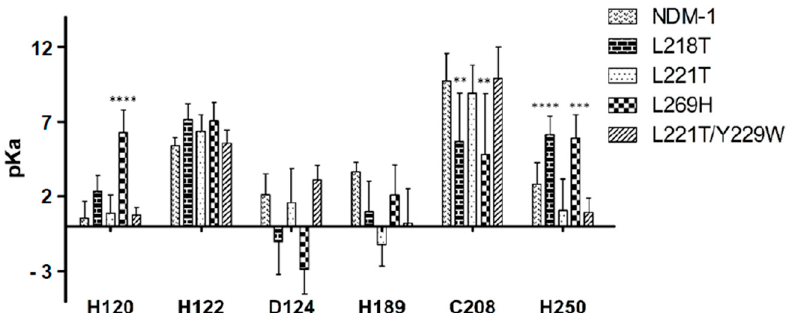
Figure 3. pKa values of the first sphere of coordination between NDM-1 and mutants calculated at pH 7. ** p = 0.003, *** p = 0.0003 and **** p < 0.0001, significantly different from NDM-1 by ANOVA test.